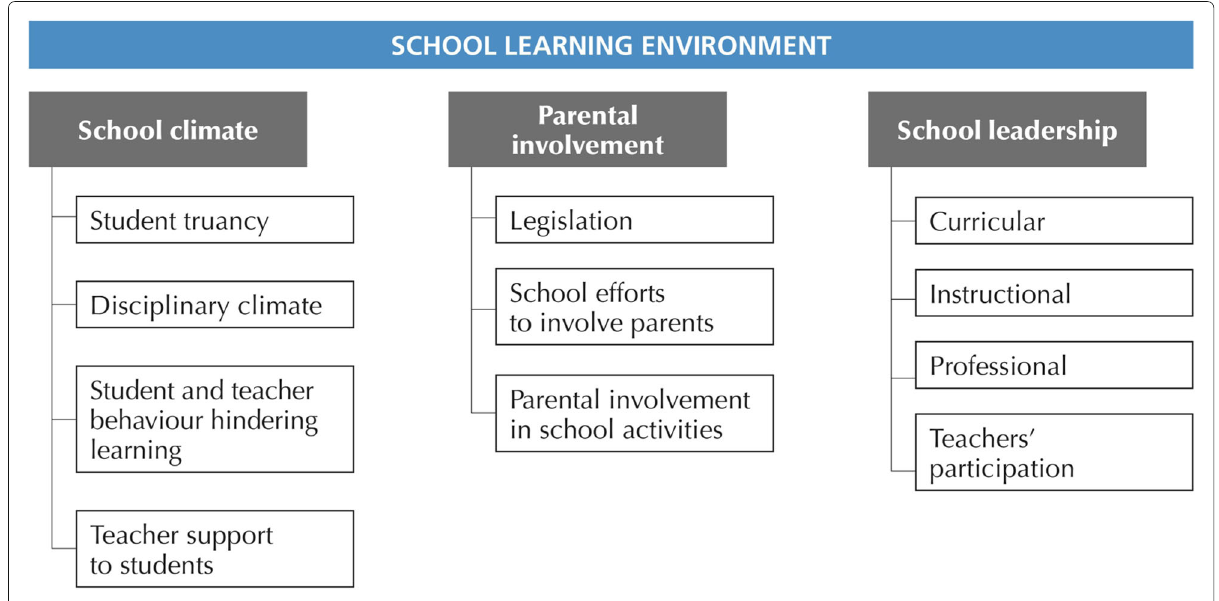
Fig. 1 Measures of school learning environment in PISA 2015 (OECD 2016b)